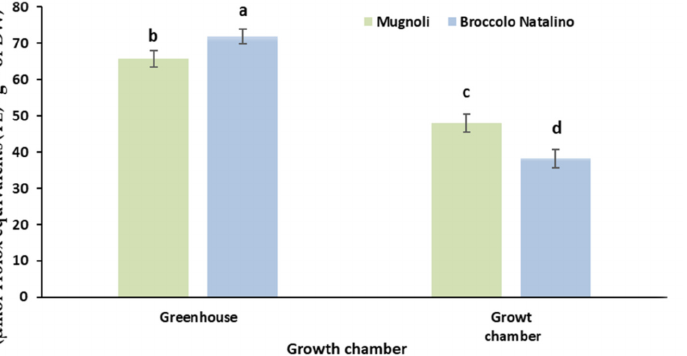
Figure 6. Polyphenols content, expressed as mg of gallic acid · g − 1 of DW, of Mugnoli and Broccolo Natalino microgreens grown in a greenhouse and in a growth chamber. Vertical bars represent ± standard deviation of mean values. Letters on the columns indicate significant differences according to Student–Newman–Keuls (SNK) test at p = 0.05.